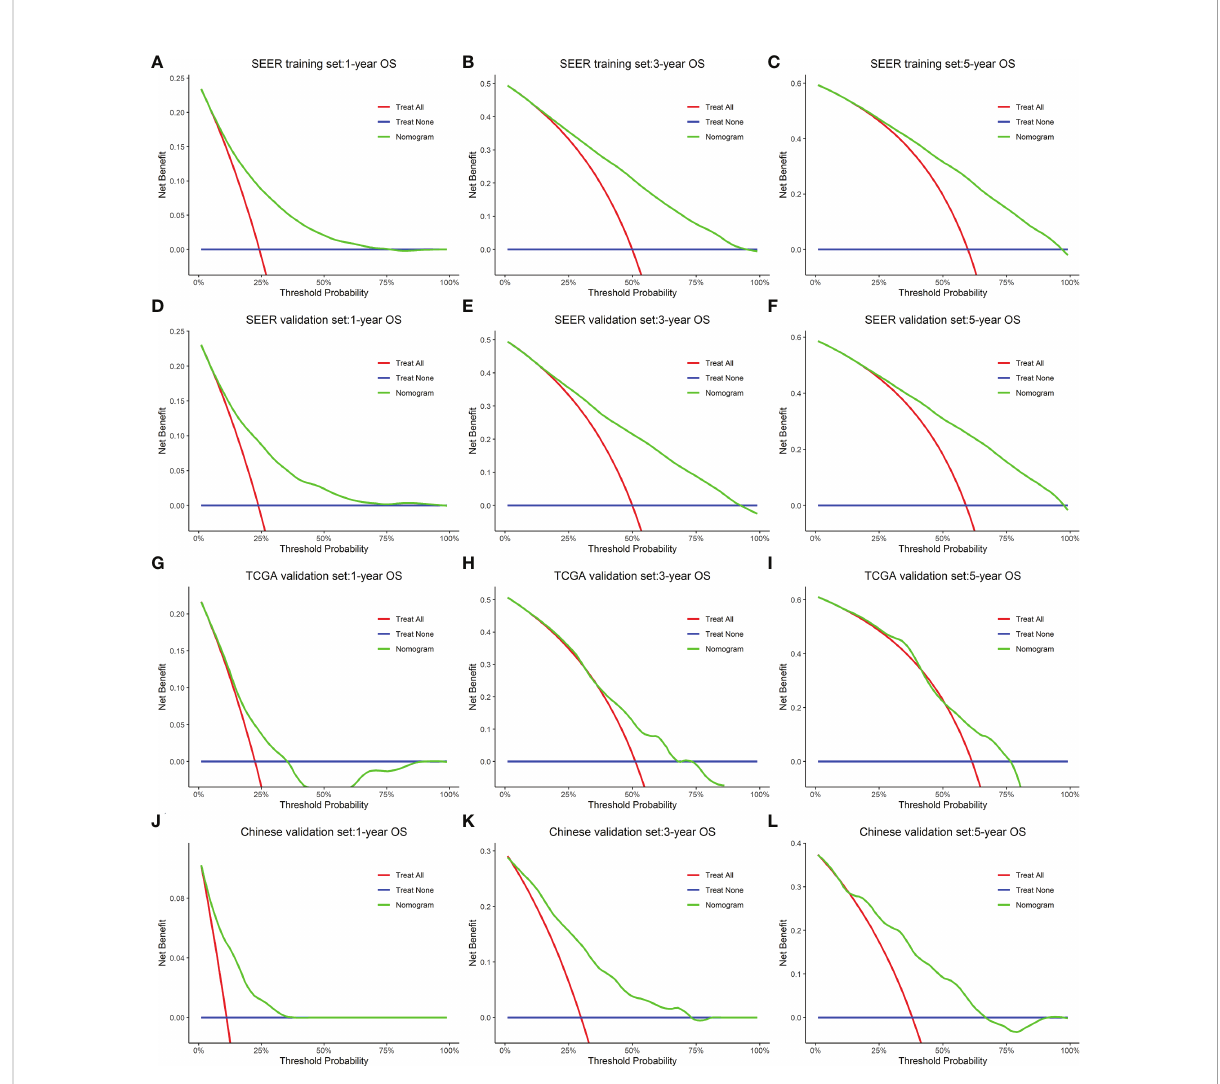
FIGURE 6 A decision curve analysis constructed for the nomogram that depicted the clinical net bene fi t for each cohort. (A – C) SEER training. (D – F) SEER internal validation. (G – I) TCGA validation. (J – L) Chinese validation set. As shown by the horizontal blue solid line, all patients are assumed not to be treated, whereas the solid red line indicates that all patients are treated. In all different cohorts, the nomogram provided superior net bene fi t across a range of threshold probabilities for decision curve